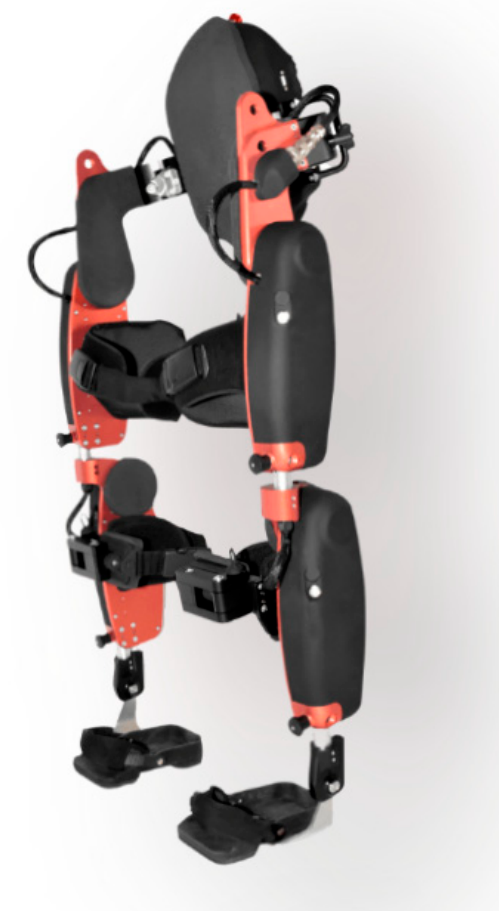
Figure 1. Sagittal view of UAN.GO, the exoskeleton used for the present case report. The device is provided of a bilateral four-joint system (hip, knee, ankle and foot), in which proximal joint are computerized (hip and knee), distal ones are fixed (ankle and foot). A central unit allows movement maps execution.